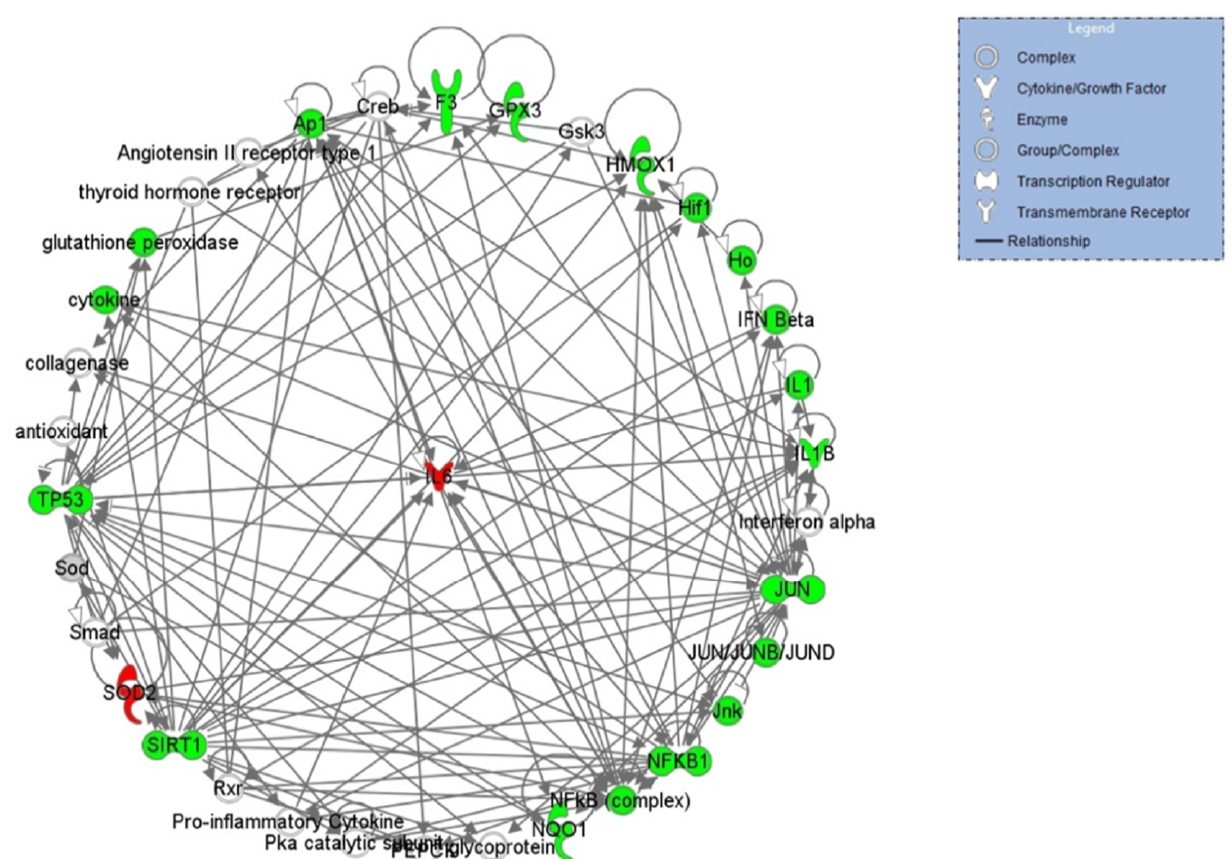
Figure 4. IPA-inferred target genes network for oxidative stress in female smokers’ cumulus cells. In red the up-regulated genes, while in green the down-regulated ones.